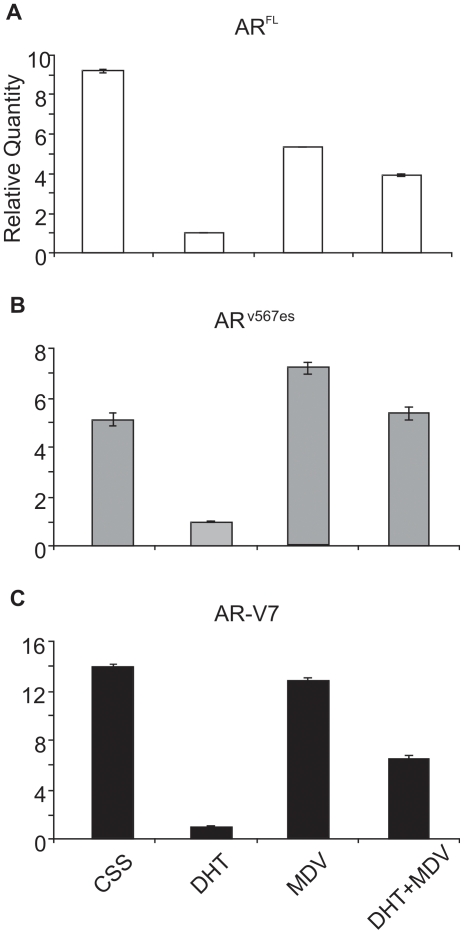
AR variant mRNA was sensitive to androgen concentration in vitro.(A) ARFL mRNA was suppressed by DHT, MDV-3100 and MDV-3100+DHT but not to the level seen by DHT alone. (B) ARv567es mRNA was suppressed in the presence of DHT, further increased by addition of MDV-3100 and suppressed to the level of CSS when DHT was added along with MDV-3100. (C) AR-V7 mRNA responded in a similar manner as ARFL.